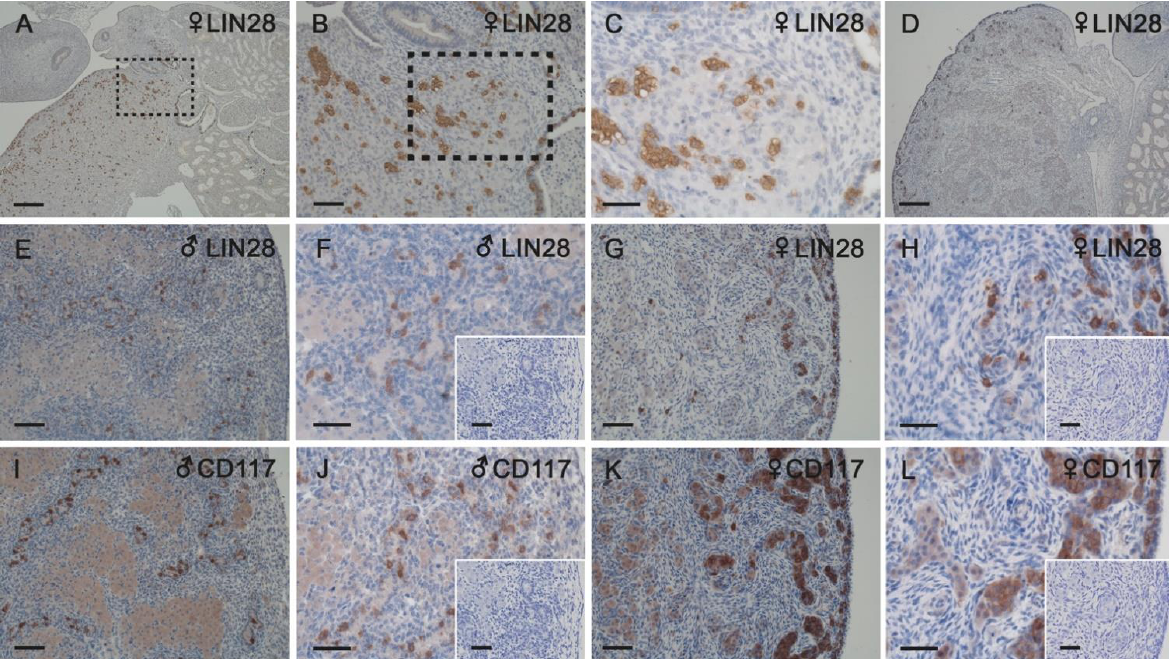
Figure 5. Immunostaining for LIN28 (marker for PGCs, A – H ) and CD117 (marker for pluripotent cells, I – L ) in female ( A – D , G , H , K , L ) and male ( E , F , I , J ) gonads from 45-day-old horse fetus ( A – C ) and 60-day-old horse fetuses ( D – L ). ( B ) Magni- fied image of area identified in ( A ). ( C ) Magnified image of area identified in ( B ). Inserts in F , H , J and L represent negative controls. At 45 days of development, PGCs were presumably migrating from the mesonephros to the gonad, but this was not the case at 60 days. PGCs were restricted to the tubular structures in males ( E , F ) and organized in cord-like structures localized in the cortical region in females ( G , H ). CD117 showed a similar distribution pattern to LIN28 ( I – L ). Scale bars in A and D : 200 µm; all other pictures: 50 µm. Table 2. Percentiles of immunofluorescent staining in gonads of horse fetuses at 60 days of gestation for single markers (Ki67, CD117, and LIN28) and respective co-localization of two markers. Ki67